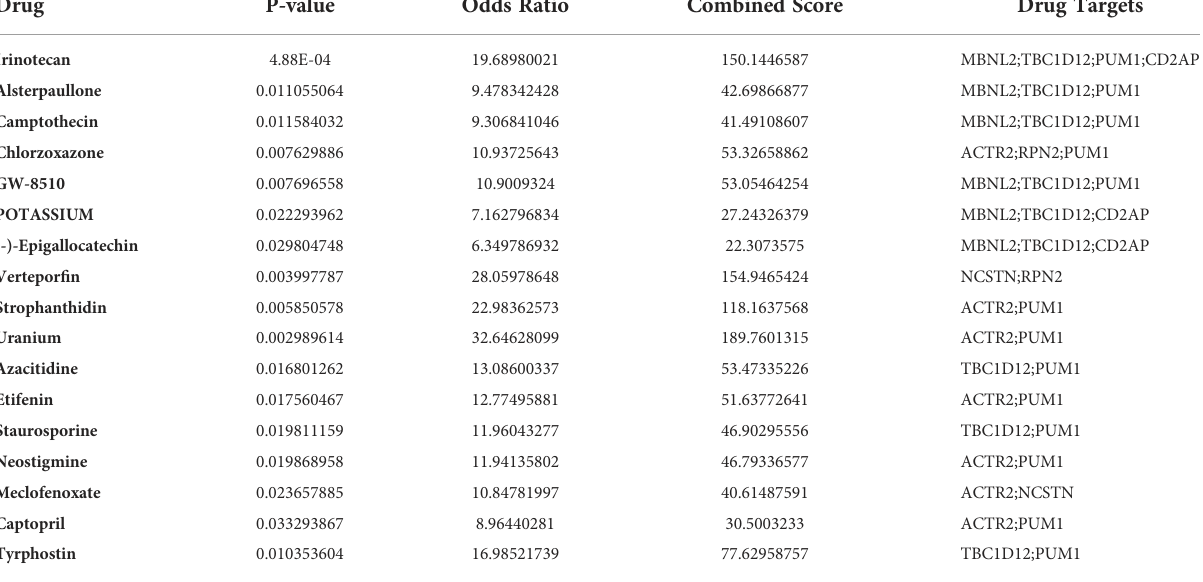
TABLE 3 Identi fi cation of RM drug candidates.